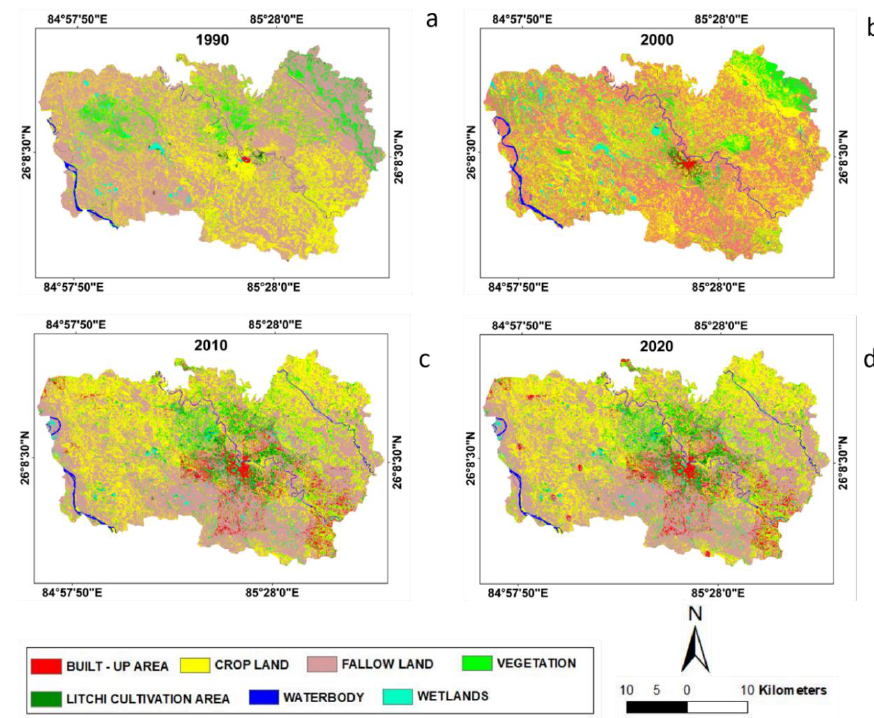
Figure 4. LULC maps of years ( a ) 1990, ( b ) 2000, ( c ) 2010, and ( d ) 2020. Table 3. Area estimates of LULC during the period of 1990 to 2020.